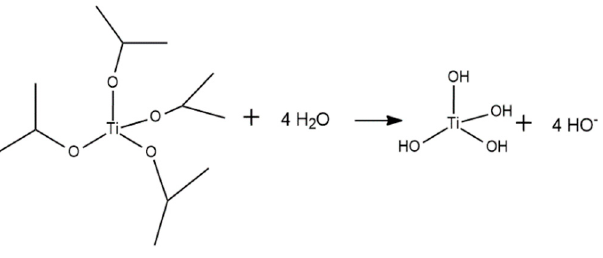
Figure A2. Hydrolysis of TiPOT.